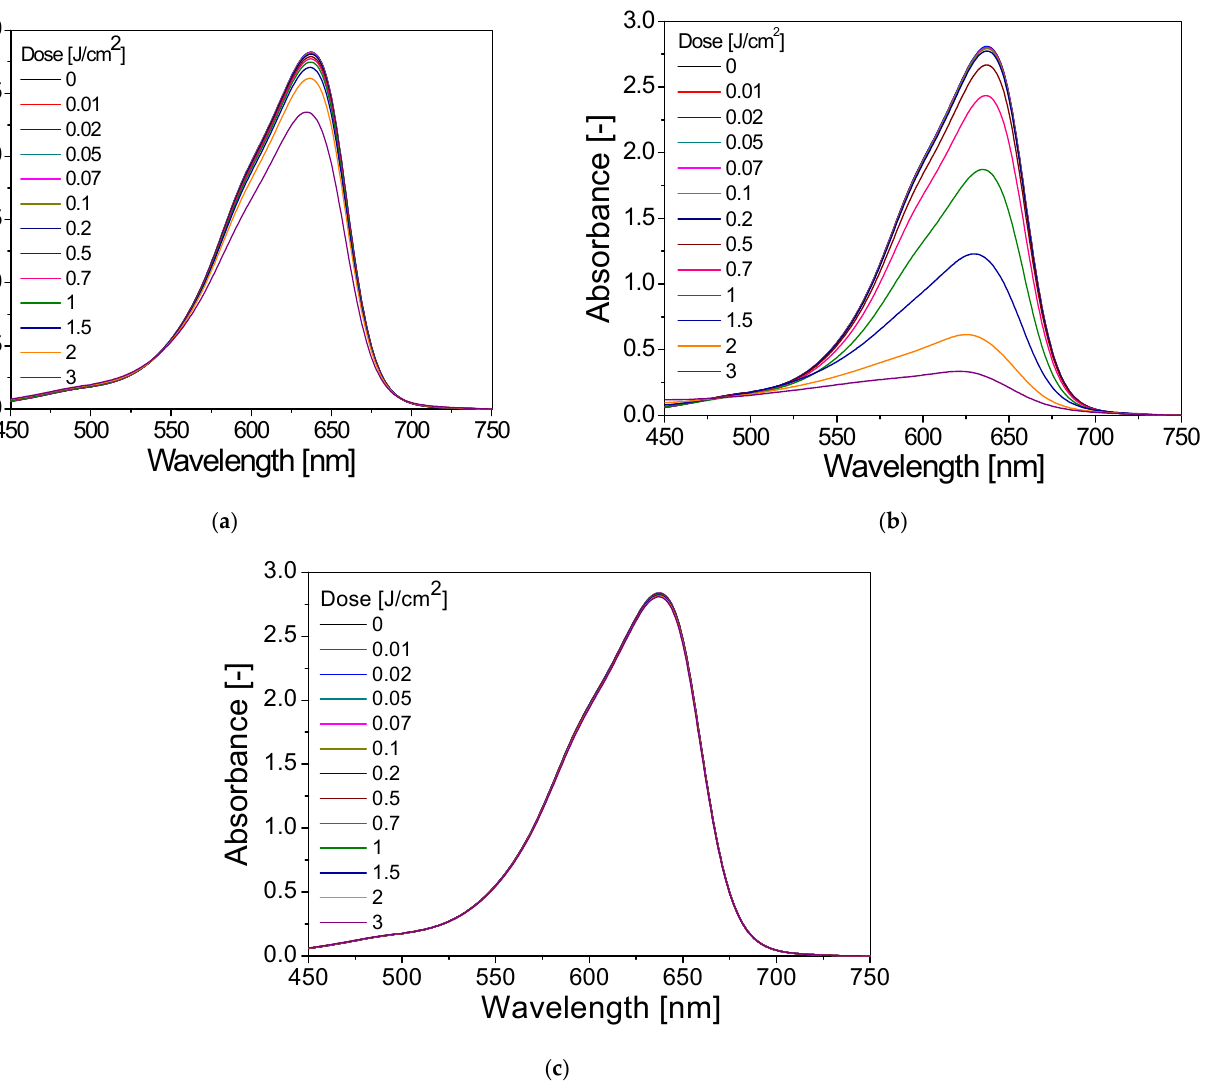
Figure 3. The absorbance spectra of optimal TBO–Pluronic F–127 dosimeter (60 µ M TBO, 5% H 2 O 2 , 25% Pluronic F–127) irradiated with UVA ( a ), UVB ( b ) and UVC ( c ) radiation in the dose range of 0–3 J/cm 2 .